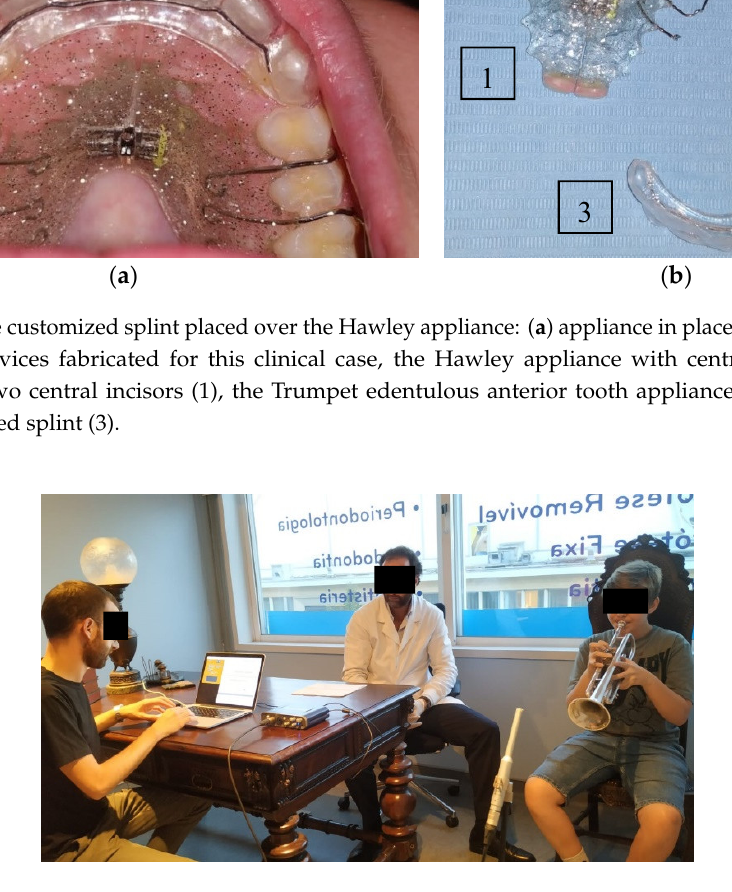
Figure 6. Capture settings of the trumpet sound quality using low-level audio descriptors.